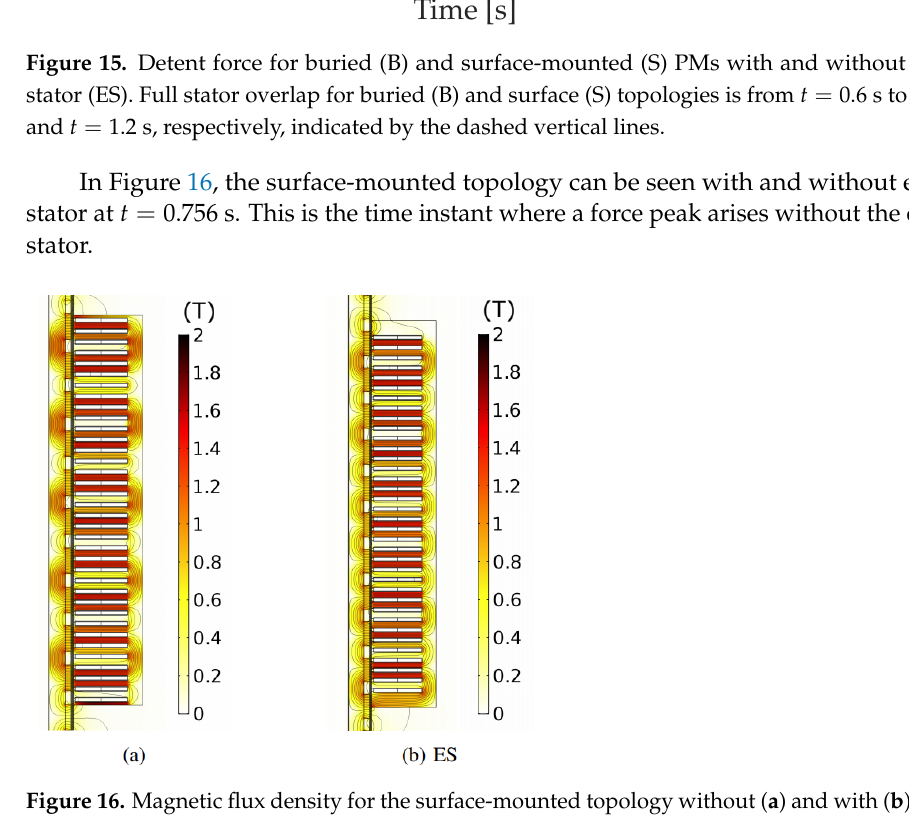
Figure 16. Magnetic flux density for the surface-mounted topology without ( a ) and with ( b ) extended stator (ES) at t = 0.756